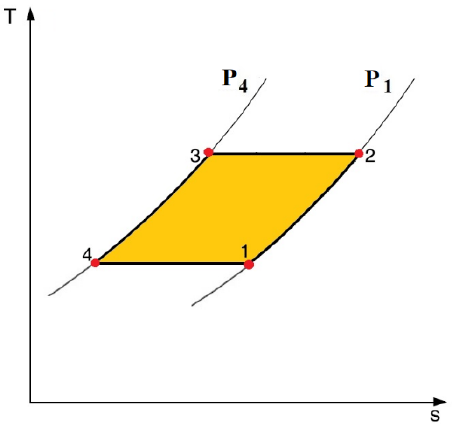
Figure 4. The four processes of the Stirling cycle for electrocaloric cooling. 2.3. The Concept of Active Regeneration and the Active Electrocaloric Regenerative Refrigeration (AER)